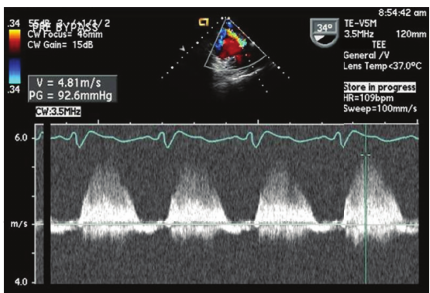
Figure 1: Intraoperative photo demonstrating severe pulmonary edema following Melody valve deployment with development of cardiogenic shock. Note complete filling of endotracheal tube with pulmonary edema fluid.